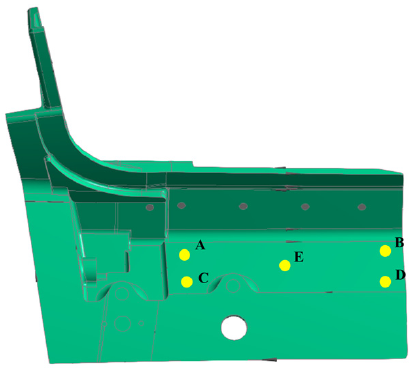
Figure 15. A–E is node position.